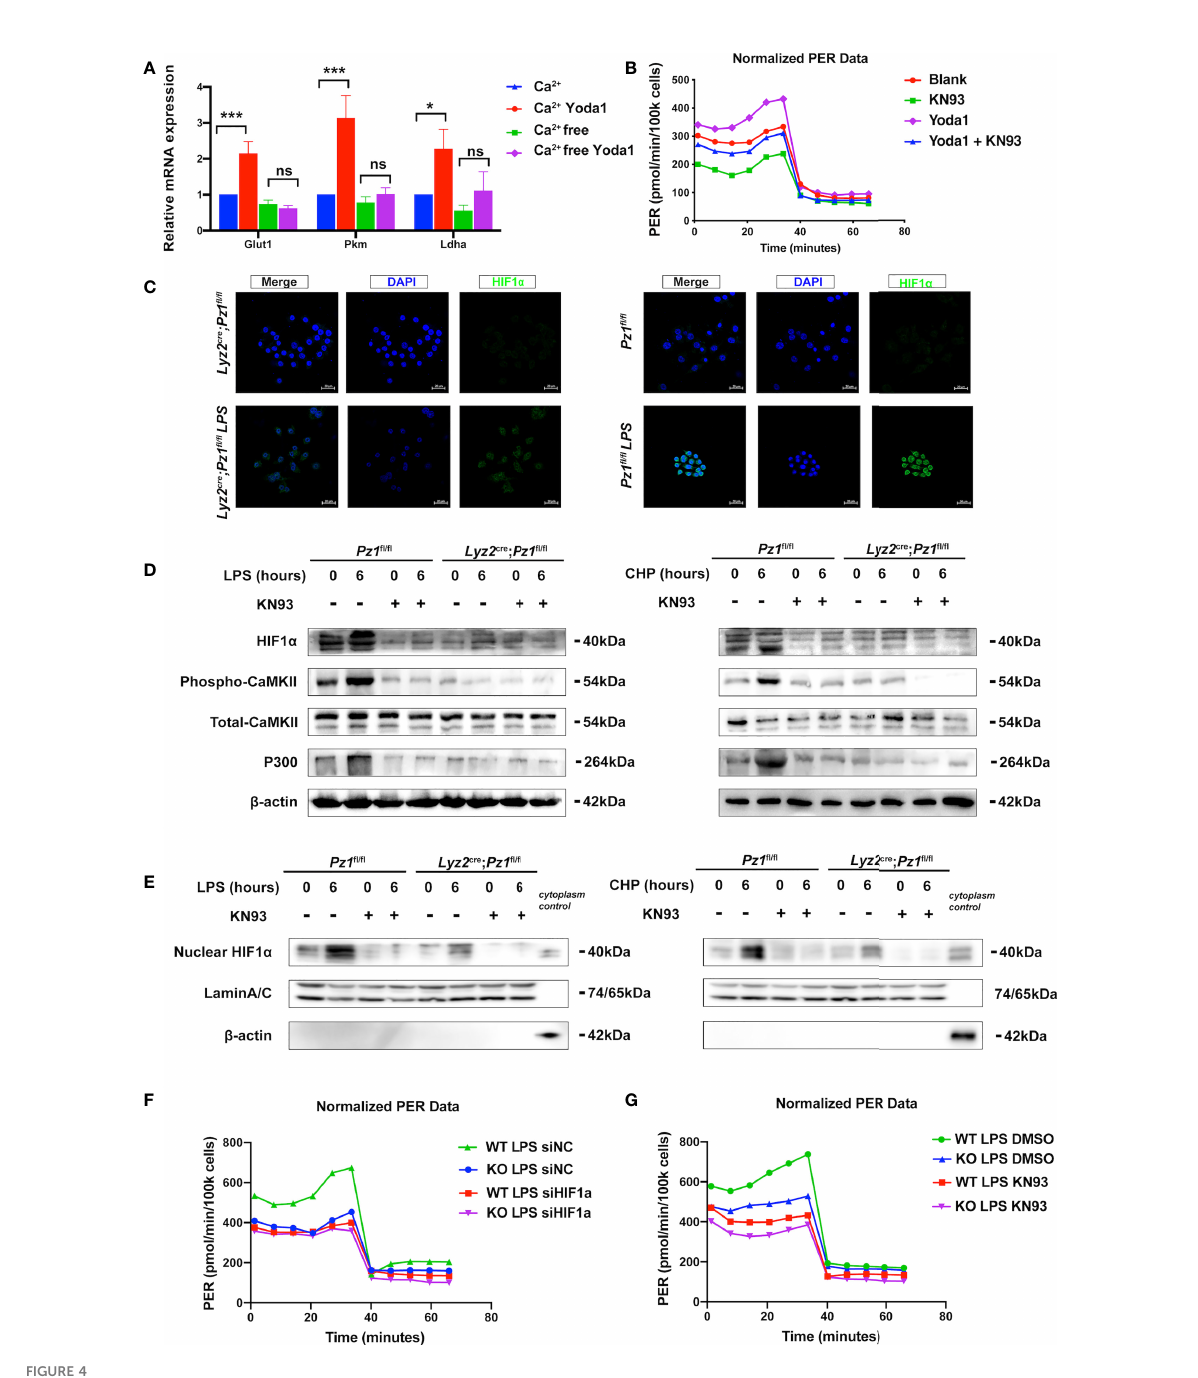
FIGURE 4 Piezo1 promotes a metabolic switch in macrophages via the Ca 2+ -CaMKII-HIF1 a axis. (A) The mRNA expression of Glut1, Pkm, and Ldha treated with 10 µM Yoda1 or DMSO for 30 min in calcium-rich or calcium-free media. (n=3, one-way ANOVA, Tukey ’ s multiple comparisons test) (B) Glycolytic rate assay pro fi le of BMDMs treated with blank (DMSO); KN93 (10uM KN93 for 24 h); Yoda1 (10uM Yoda1 for 30 min and overnight culture); Yoda1+KN93 (10uM Yoda1 for 30 min and 10uM KN93 for 24 h) (C) Immuno fl uorescence of HIF1 a in the BMDMs from Lyz2 cre/+ Piezo1 fl ox/ fl ox mouse and Piezo1 fl ox/ fl ox control mice treated with or without LPS (10 ng/ml) for 24 h. (D, E) HIF1 a , phospho-CaMKII, total-CaMKII, P300, b -actin, and LaminA/C, nuclear HIF1 a expression in BMDMs in the indicated conditions (10 ng/ml LPS for 0 or 6 h, 10 µM KN93 for 0 or 6 h, static pressure or cyclical hydrostatic pressure for 0 or 6 h). (F) Glycolytic rate assay pro fi le of BMDMs from Lyz2 cre/+ Piezo1 fl ox/ fl ox mice or Piezo1 fl ox/ fl ox control mice treated with siNC or siHIF1 a . (G) Glycolytic rate assay pro fi le of BMDMs from Lyz2 cre/+ Piezo1 fl ox/ fl ox mice or Piezo1 fl ox/ fl ox control mice treated with DMSO or 10 uM KN93 for 24 h. Data are expressed as the mean ± SD. *P < 0.05, ***P < 0.001; ns, not signi fi cant. BMDMs, bone marrow-derived macrophages; Lyz2 cre/+ Piezo1 fl ox/ fl ox , conditionally Piezo1-de fi cient mice; HIF1 a , hypoxia-inducible factor 1 a